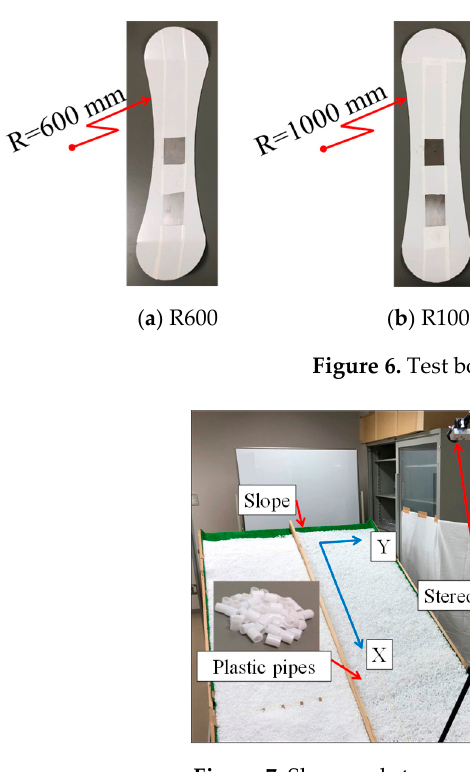
Figure 5. Experimental device.